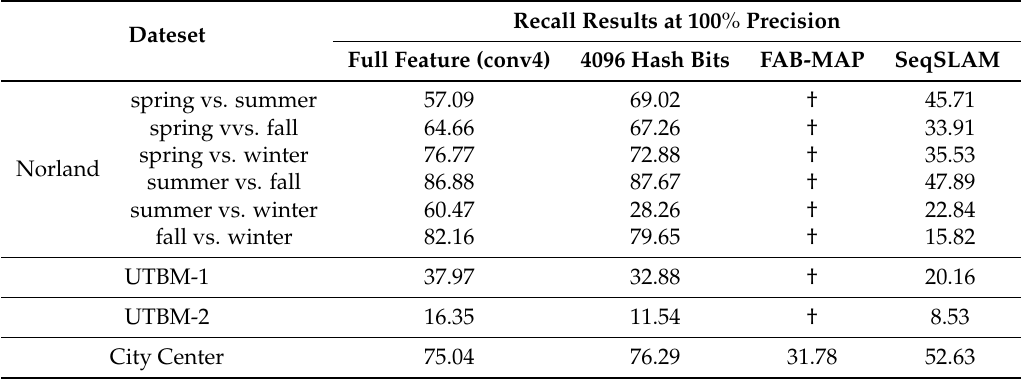
Table 5. The recall results at 100% precision. The † means the accuracy is smaller than